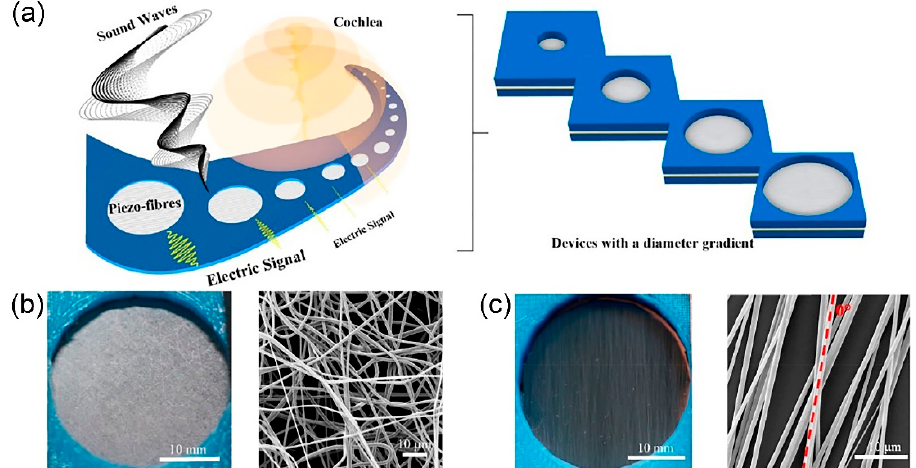
Figure 23. ( a ) The circular membranes of different diameters are fabricated using random and aligned P(VDF-TrFE) nanofibers, mimicking the function of a basilar membrane. The fibrous microphone membrane is based on electrospun piezoelectric polymer nanofibres with ( b ) random P(VDF-TrFE) fibres and ( c ) aligned P(VDF-TrFE) fibres [84]. Further permissions related to the material excerpted should be directed to the ACS.